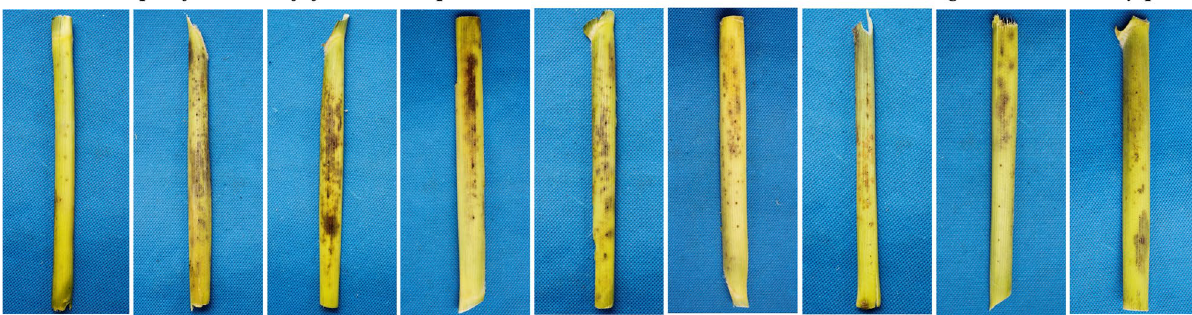
Figure 6. Inoculation of maize sheaths with different Fusarium spp. isolates (the maize cultivar is Chuandan